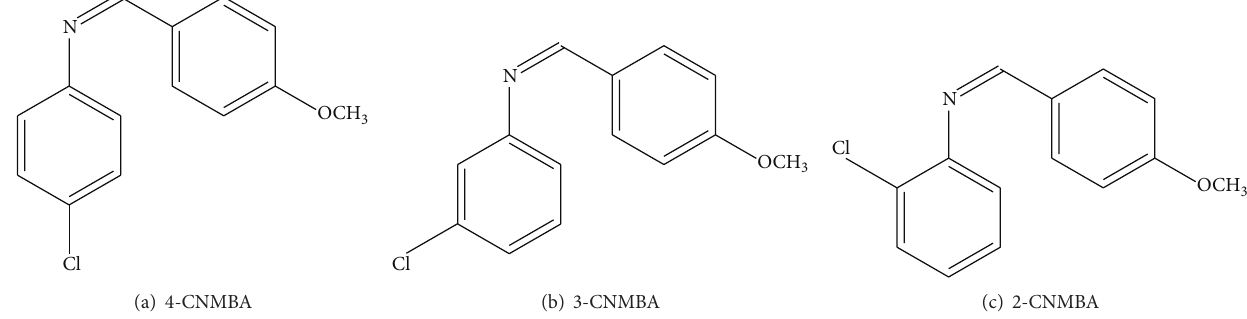
Figure 1: Molecular structure of studied compounds (a) 4-CNMBA, (b) 3-CNMBA, and (c)